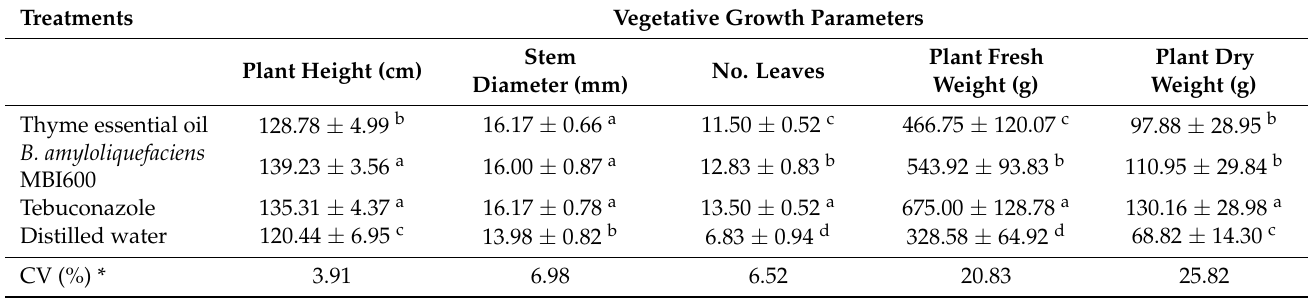
Table 4. Effect of the application of thyme essential oil on the vegetative growth parameters of tomato plants infected by Alternaria linariae .